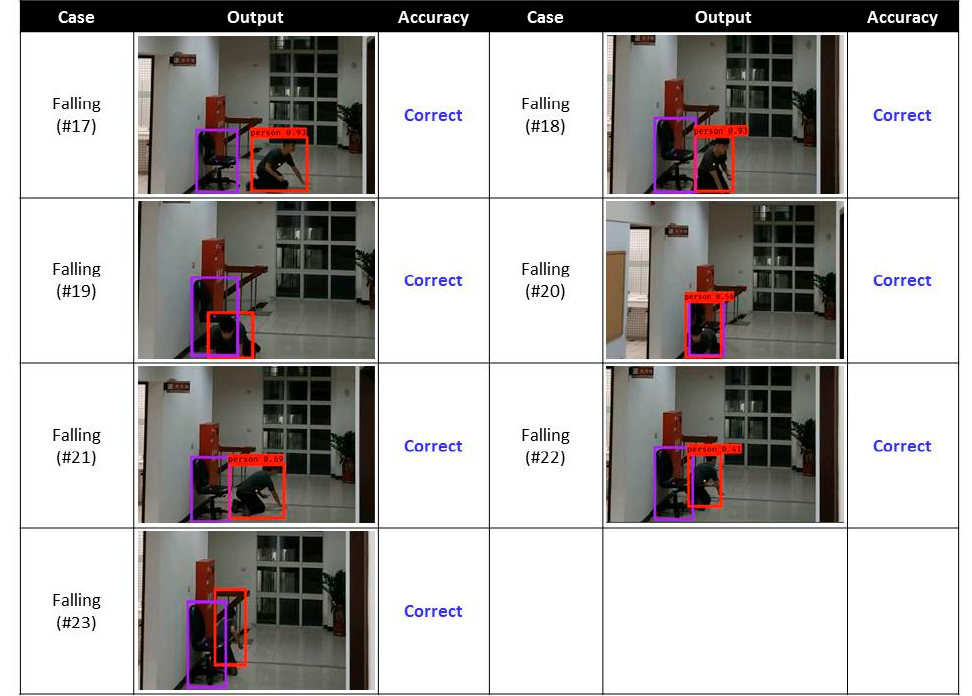
Figure 11. The test results of the effect of colors on IFADS’s accuracy.